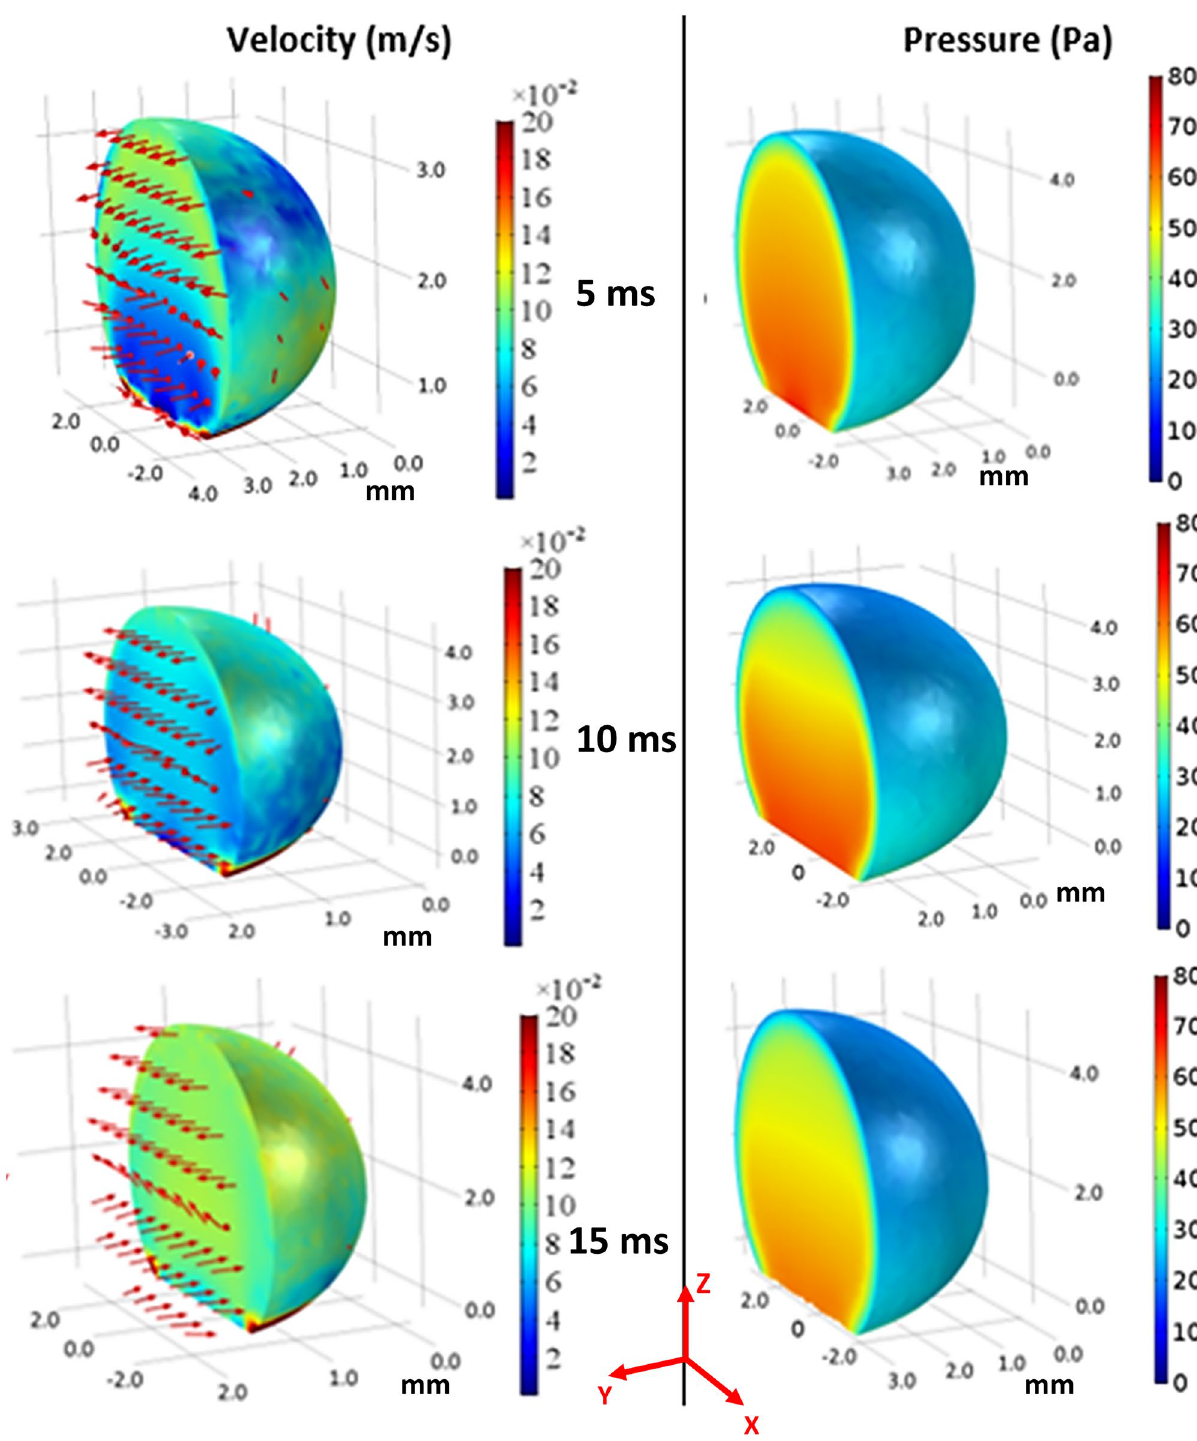
Figure 5. 3D velocity field and pressure distributions inside rolling droplet at different durations. Droplet volume is 40 µL, the inclination angle is δ = 5° and micro-post spacing is b = 50 µ m